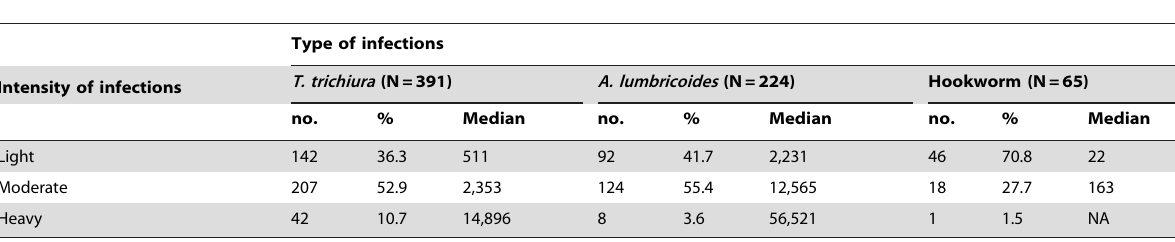
Table 2. Intensity of STH infections among rural children in West